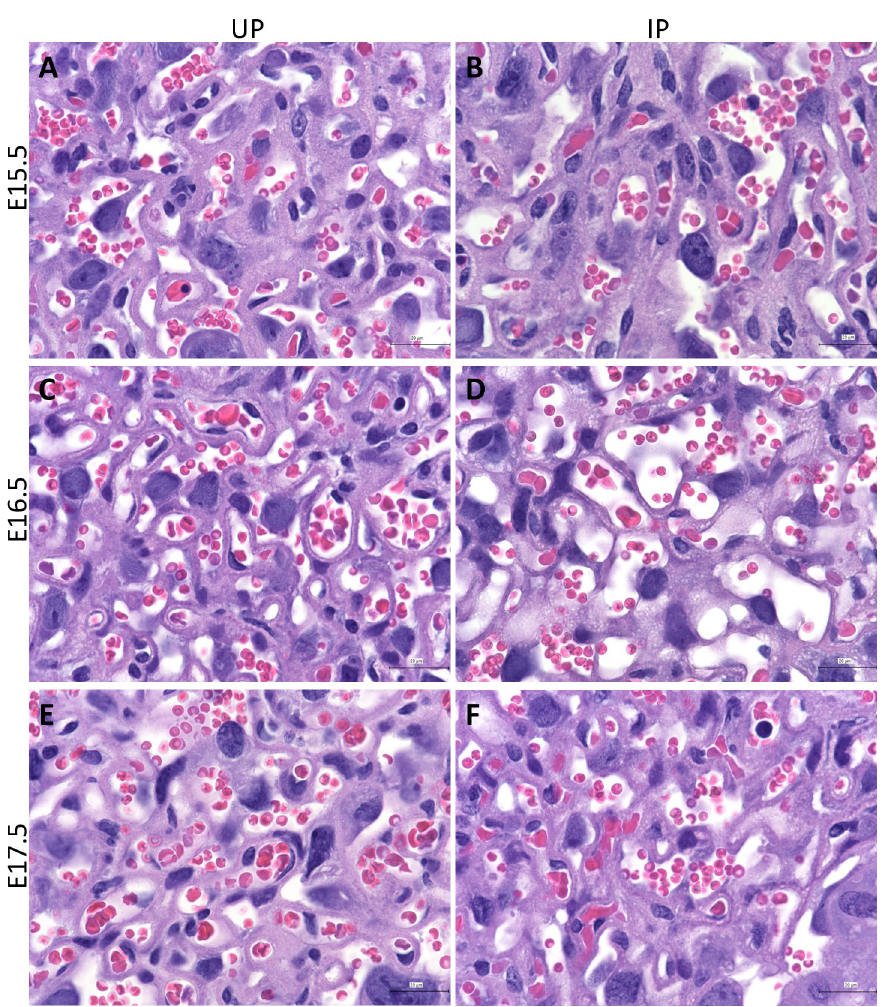
Fig 4. P . chabaudi AS - infected red blood cells in the placental labyrinth region one day prior to preterm delivery. (A, C, E) micrographs taken with 100x objective lens from uninfected pregnant (UP) controls at E15.5, E16.5, and E17.5. (B, D, F) micrographs from infected pregnant (IP) dams sacrificed one day prior to preterm delivery on E15.5, E16.5, and E17.5, respectively. both TNF -/- and TNFRI -/- IP mice experienced preterm delivery after E16.5, similar to wild- type B6 mice (Fig 7). Although parasitemia appears to be higher in TNF -/- IP compared to B6 mice, AUC analysis revealed no significant differences between the groups for either TNF -/- or TNFRI -/- IP dams (S6 Fig). Taken together, these data demonstrate that TNF and TNF signal- ing through TNFRI are not required to drive preterm delivery in mice infected on E8.5. Oxidative stress, generally described as an imbalance between the formation of free radicals, such as reactive oxygen species (ROS), and antioxidant defense molecules within cells and tis- sues, leads to cellular damage to lipids, proteins, RNA, and DNA. Recently, oxidative stress has been documented to play a crucial role in pregnancy outcome in some mouse models of PM [20, 23, 24] and is implicated in women experiencing malaria during pregnancy [14, 15] as well as other types of pregnancy complications [44, 47, 48]. To interrogate the role of oxidative stress in this model, placentae were evaluated for alterations in antioxidant gene expression by RT- qPCR (Fig 8). In the placentae of B6 mice infected on E8.5, placental transcript abundance at